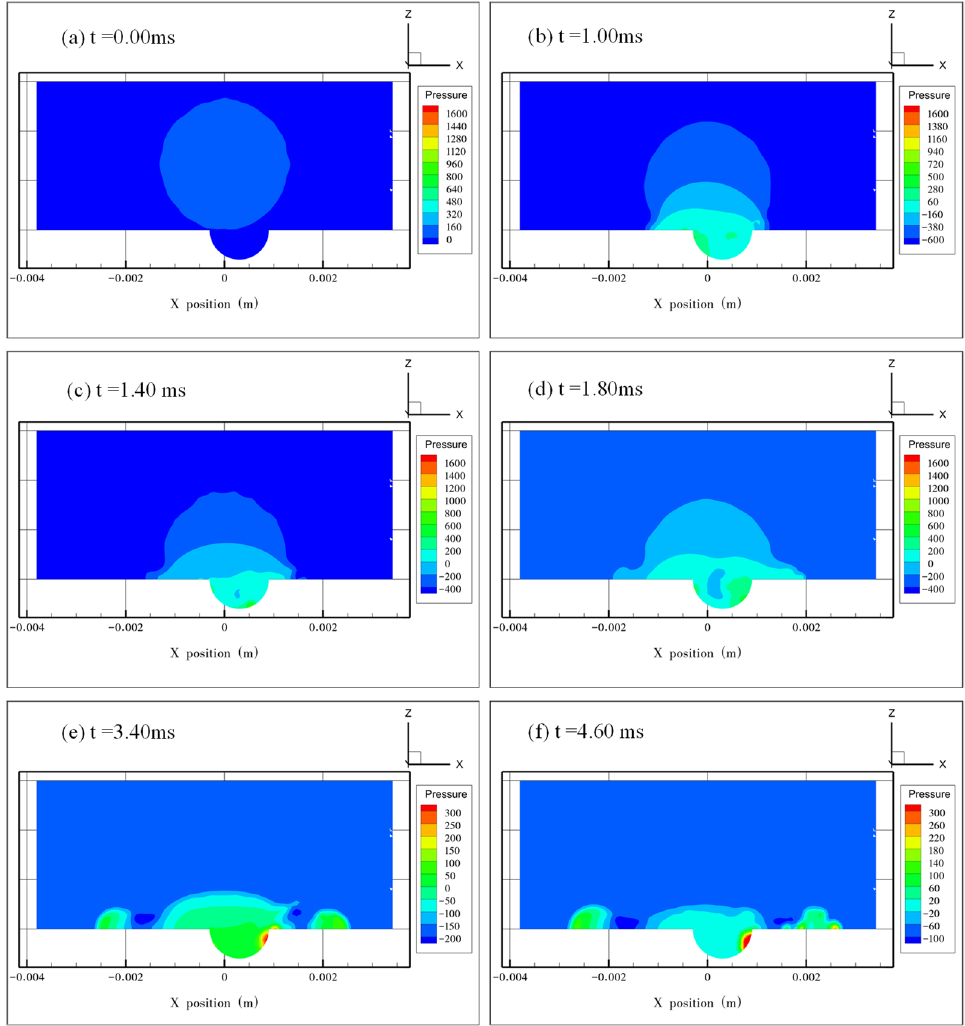
Figure 9. Pressure distribution inside the droplet at e = 0.25. ( a ) The initial pressure distribution when the droplet starts to impact the surface at t = 0.00 ms. ( b – d ) The maximum pressure moves from the left side to the right side of the dimple along with droplet spreading. ( e ) Pressure distribution after the air is evacuated from the dimple. ( f ) Pressure distribution when the droplet spreads to its maximum